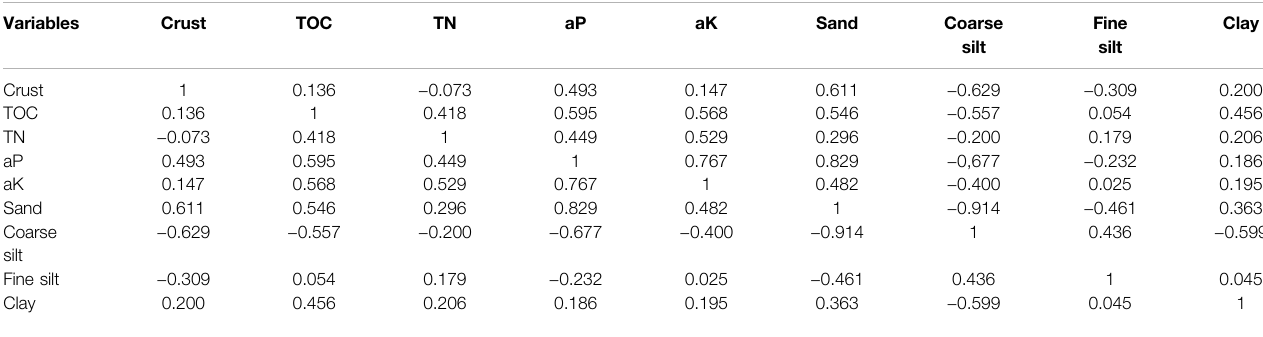
TABLE 7 | Spearman correlation matrix ( p ≤ 0.05) of crust and selected soil parameters.